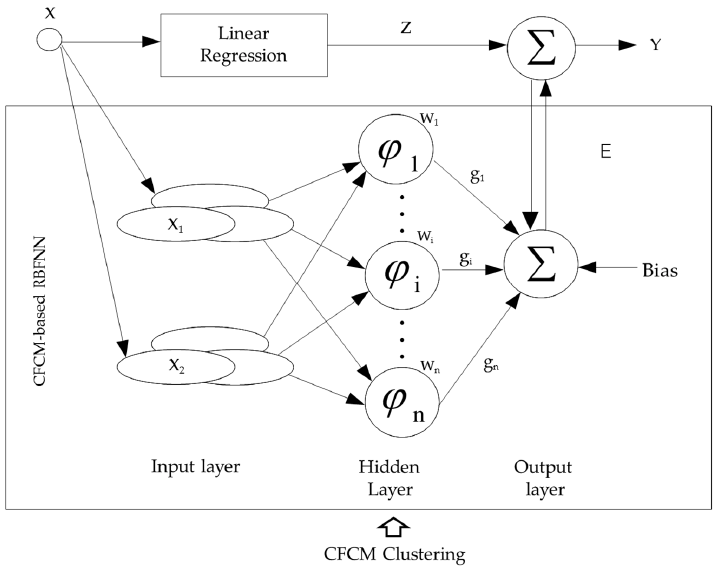
Figure 3. Overall flow of processing realized in the design of incremental RBFNN.